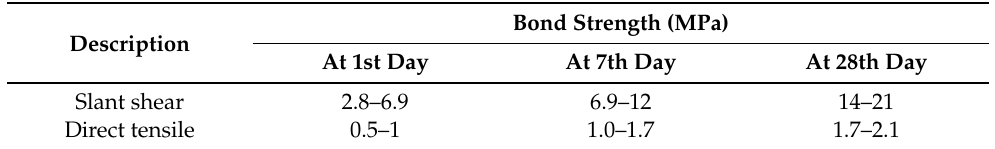
Table 5. Minimum acceptable slant shear and direct tensile bond strengths according to ACI